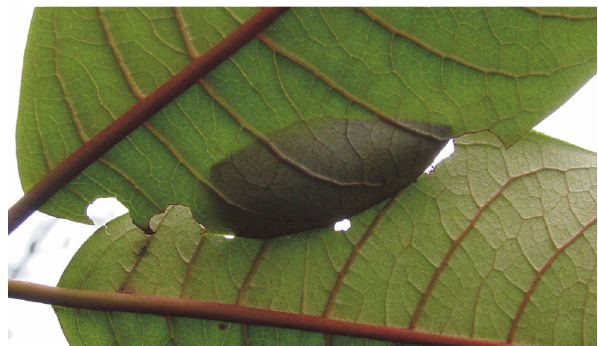
Figure 5. Last instar larval shelter of P. papius